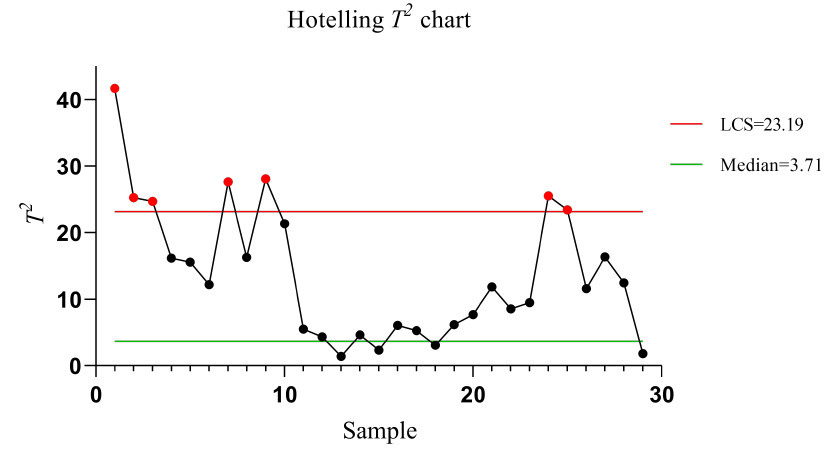
Figure 10. T 2 for variables of the industrial case of cheese